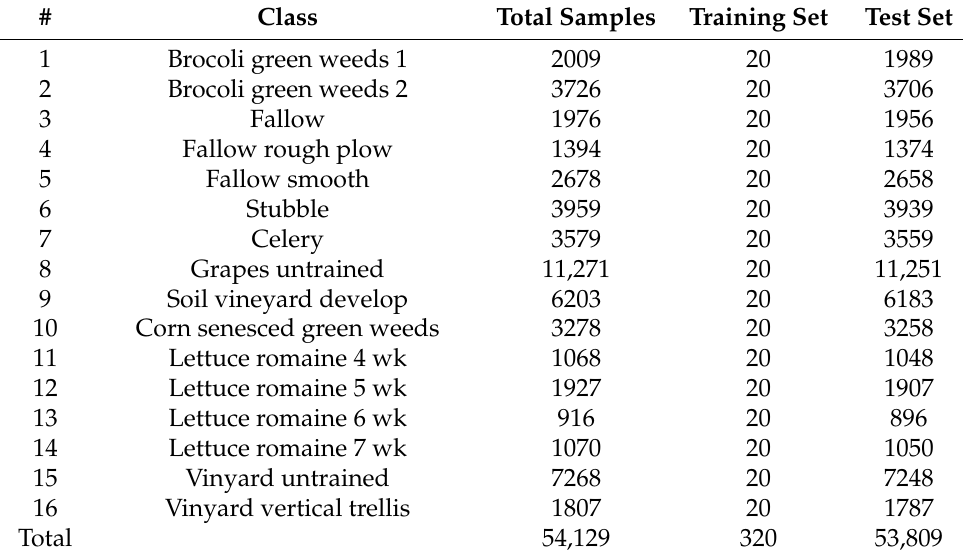
Table 2. The number of samples in each category in the Salinas dataset.